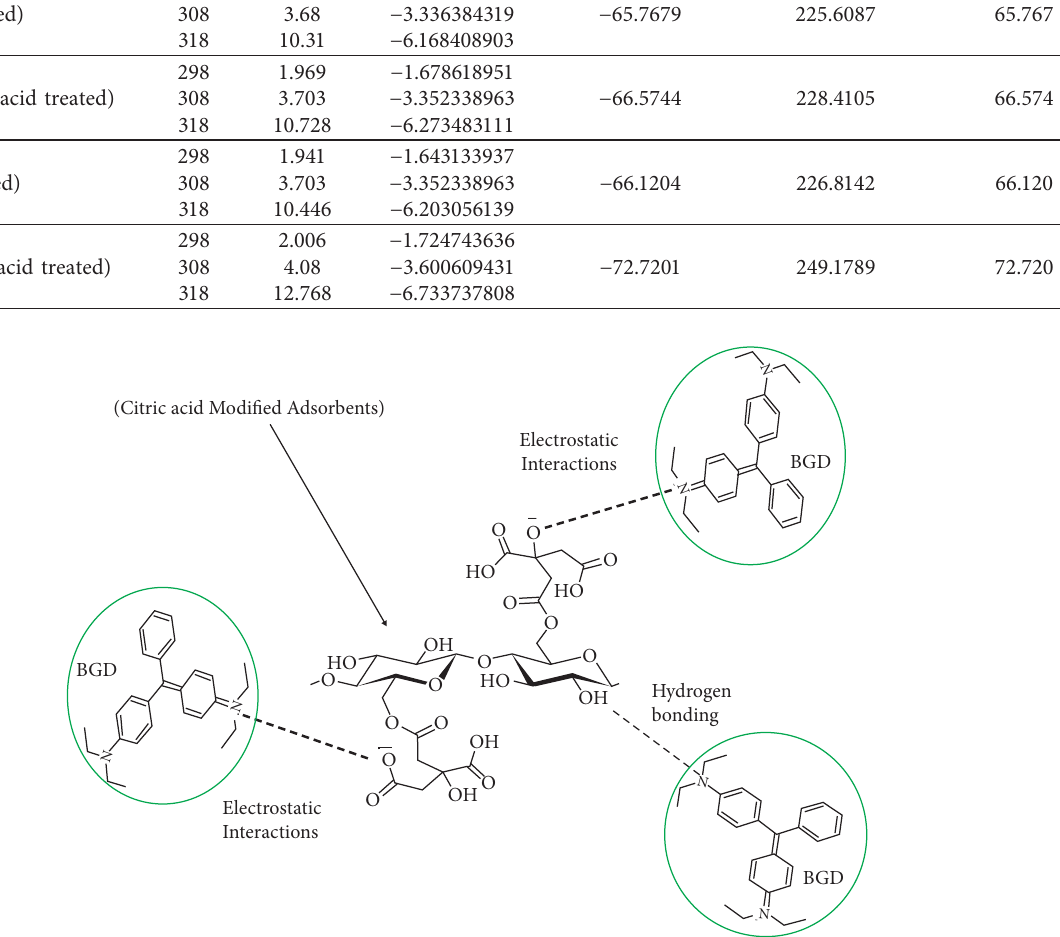
Figure 18: Schematic proposed adsorption mechanism of BGD on